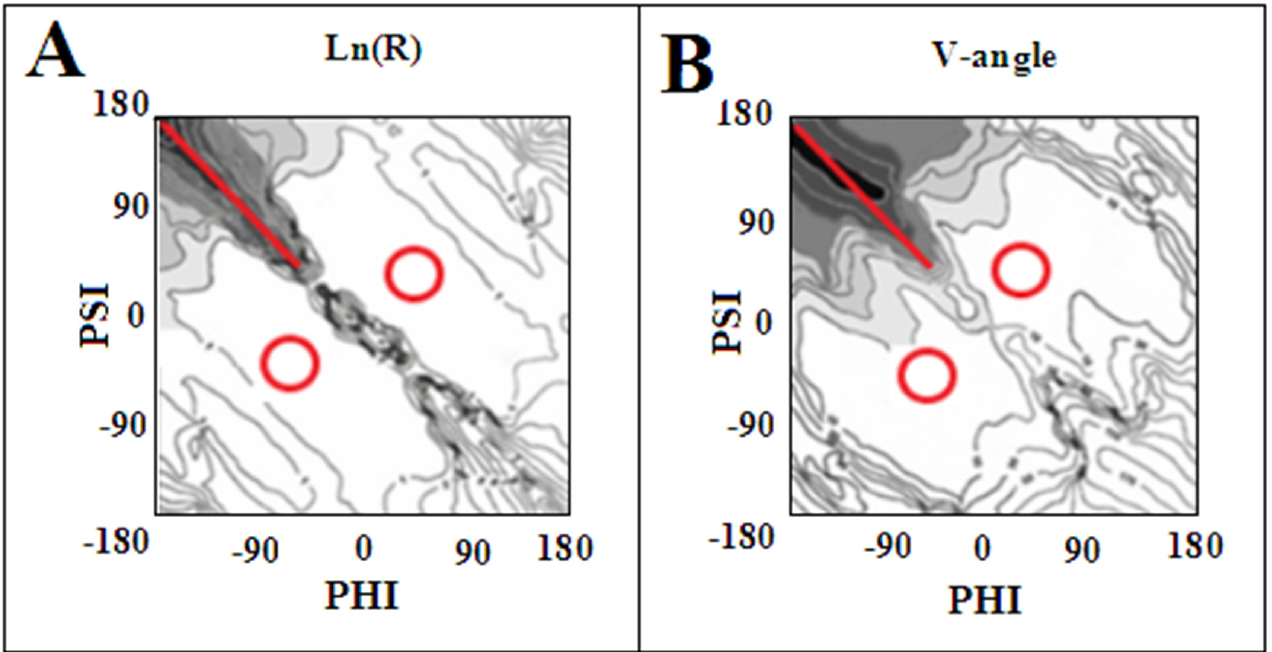
Figure 15. Maps of the distribution of geometric parameters describing the structure of the polypep- tide: ( A )—radius of curvature on the Ln (R) scale; ( B )—V-angle—the size of the rotation angle areas that meet the conditions |Psi| = |Phi| are highlighted with a red line and red circles.